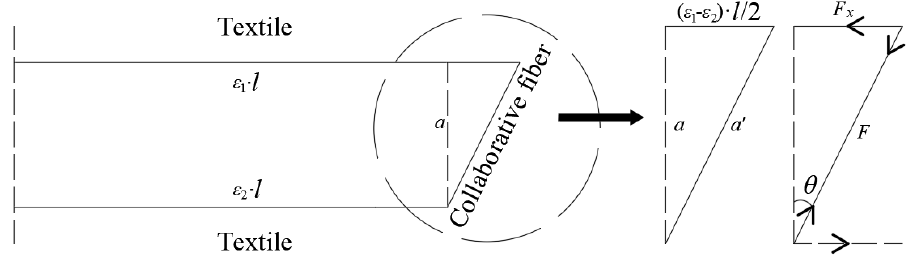
Figure 7. Deformation of 3D textile during compression.